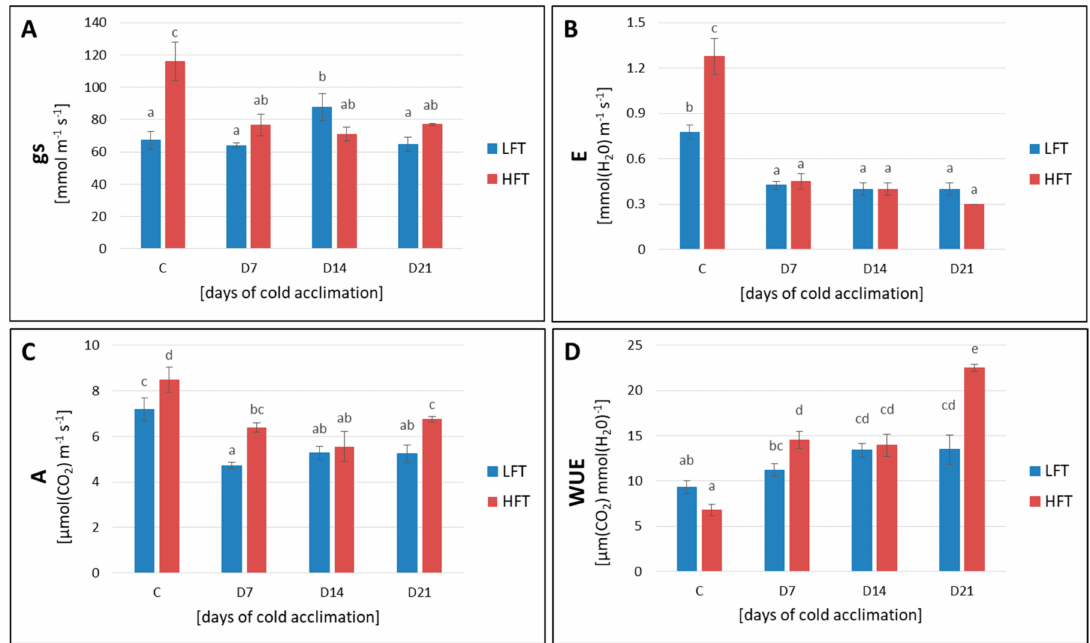
Figure 3. Stomatal conductance ( gs ) ( A ), transpiration rate ( E ) ( B ), assimilation of CO 2 ( A ) ( C ), and water use e ffi ciency ( WUE ) ( D ) in the high (HFT) and the low freezing tolerant (LFT) Lolium multiflorum / Festuca arundinacea introgression forms, at four time-points: before cold acclimation (CA) C and on the 7th, 14th, and 21st day of CA. Error bars represent the standard errors of four replicates. Homogeneity groups are denoted by the same letters, according to Fisher’s LSD test ( p =